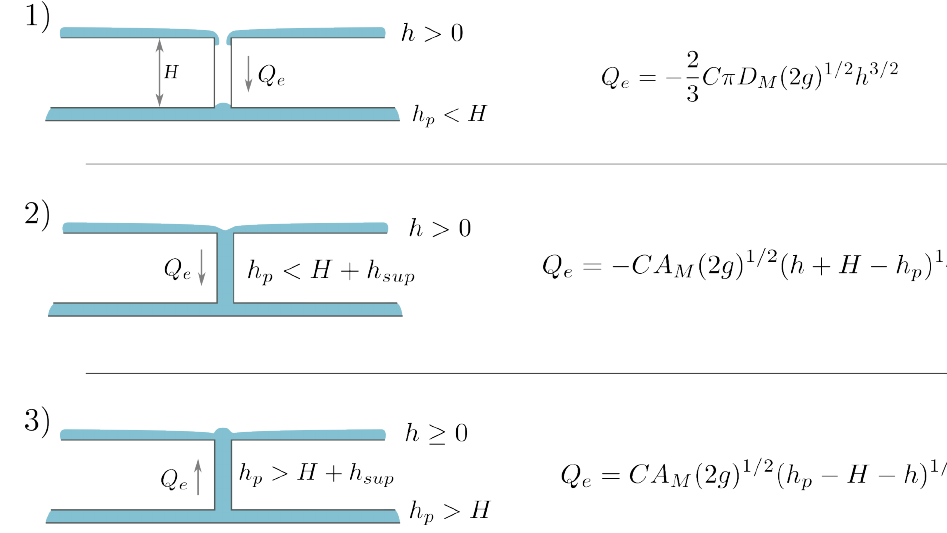
Figure 3. Possible hydraulic scenarios in the coupled